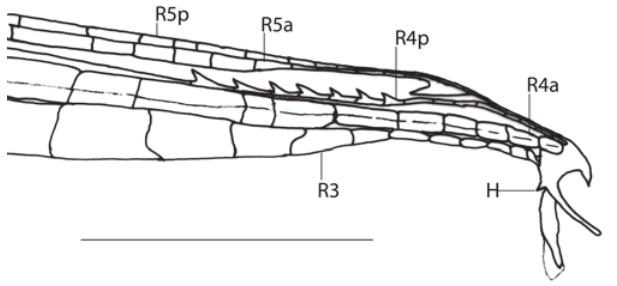
Fig. 47. Gonopodium tip of Phalloceros pellos , MHNCI 9068. R3, R4a, R4p, R5a, R5p indicate gonopodial rays. Scale bar 1 mm.